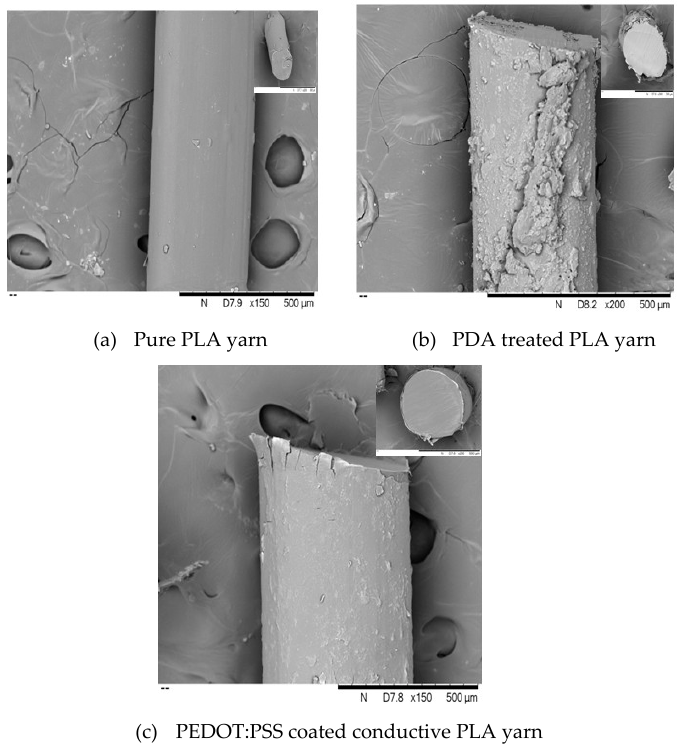
Figure 10. SEM images (surface and cross-section) of PLA yarn at various stages.